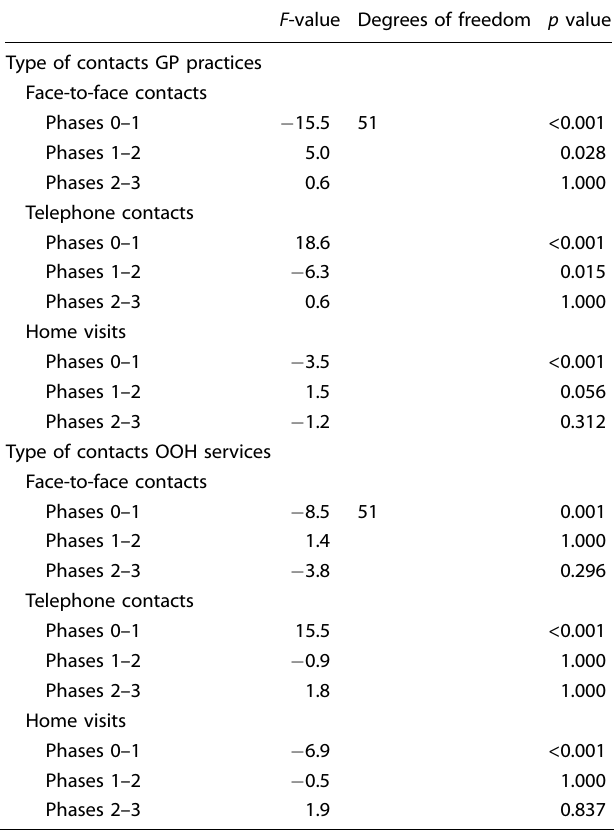
Table 3. Differences between the phases in 2020 for the type of contact, both for GP practices and OOH